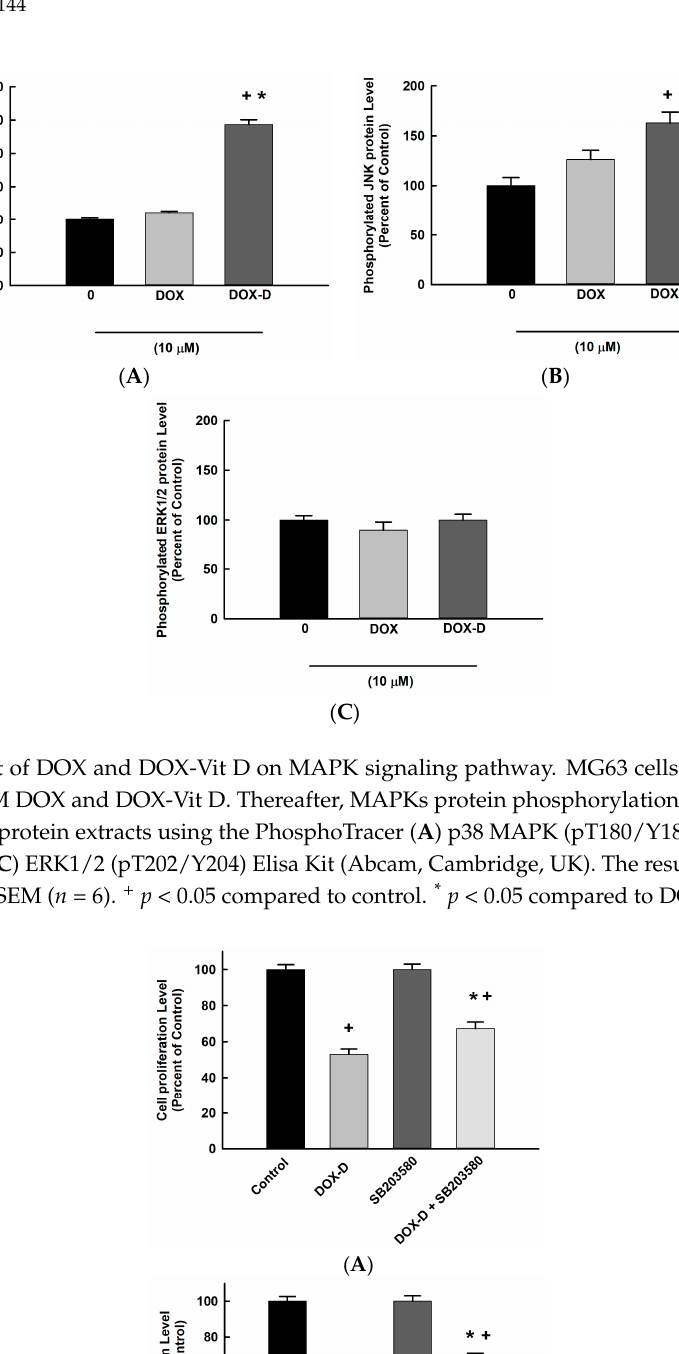
Figure 8. Effect of MAPK inhibitors on DOX-Vit D-induced cytotoxicity. MG63 cells were treated with